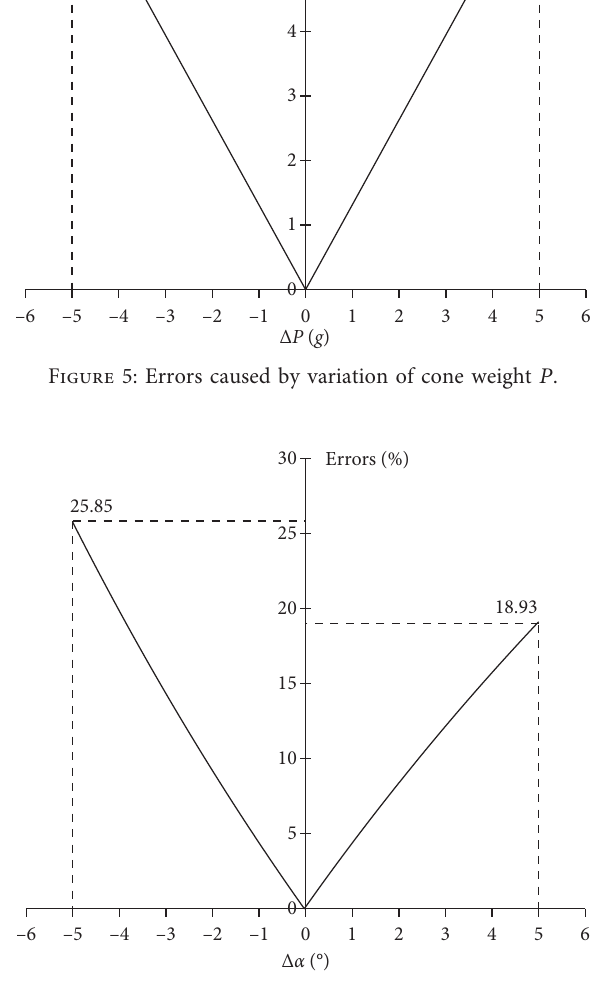
Figure 6: Errors caused by variation of cone angle α